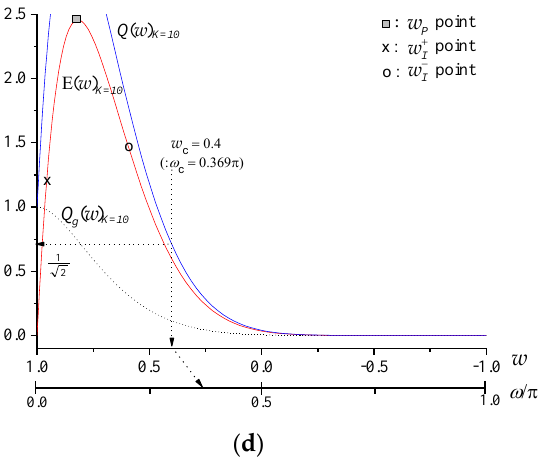
(cid:0) (cid:1) ) due to 𝐾 for 𝑁 = 11 and 𝑤 ) due to 𝐾 for 𝑁 = 11 and 𝑤 w ± Figure 3. Q g ( w ) , E ( w ) , and Q ( w ) and the relation between , w P , w c due to K for N = 11 and 𝑐 = 0.4 ( 𝜔 𝑐 = 𝑃 ,𝑤 𝑐 𝑐 = 0.4 ( 𝜔 𝑐 = 𝑃 ,𝑤 𝑐 I < w c as K = 5, ( b ) w < w c < w + < w c < w w c = 0.4 ( ω c = 0.369 π ): ( a ) w + as K = 7, ( c ) w − P P as I I I K = 9, and ( d ) w c < w − as K = 10. I